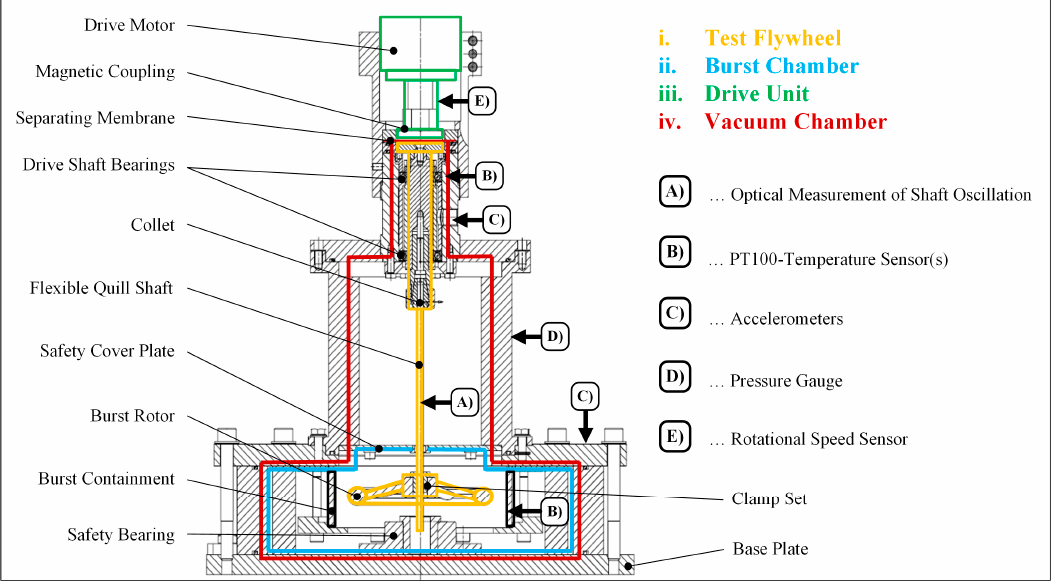
Figure 8 . Schematics of the burst test rig (final design) including measurement technology. Figure 8. Schematics of the burst test rig (final design) including measurement